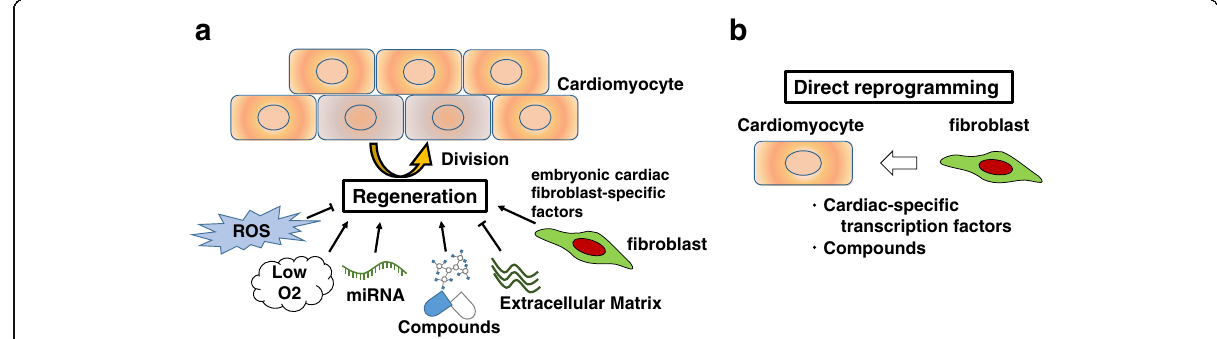
Fig. 2 Current strategies for cardiomyocyte regeneration. a Endogenous cardiac regeneration is primarily driven by the division of pre-existing CMs; currently, paracrine factors, the microenvironment, and small molecules that regulate this process are under investigation. b The direct reprogramming of cardiac fibroblasts into CMs is induced by a combination of cardiac-specific transcription factors and compounds. Investigations to improve the efficiency and maturity of generated CMs are currently in